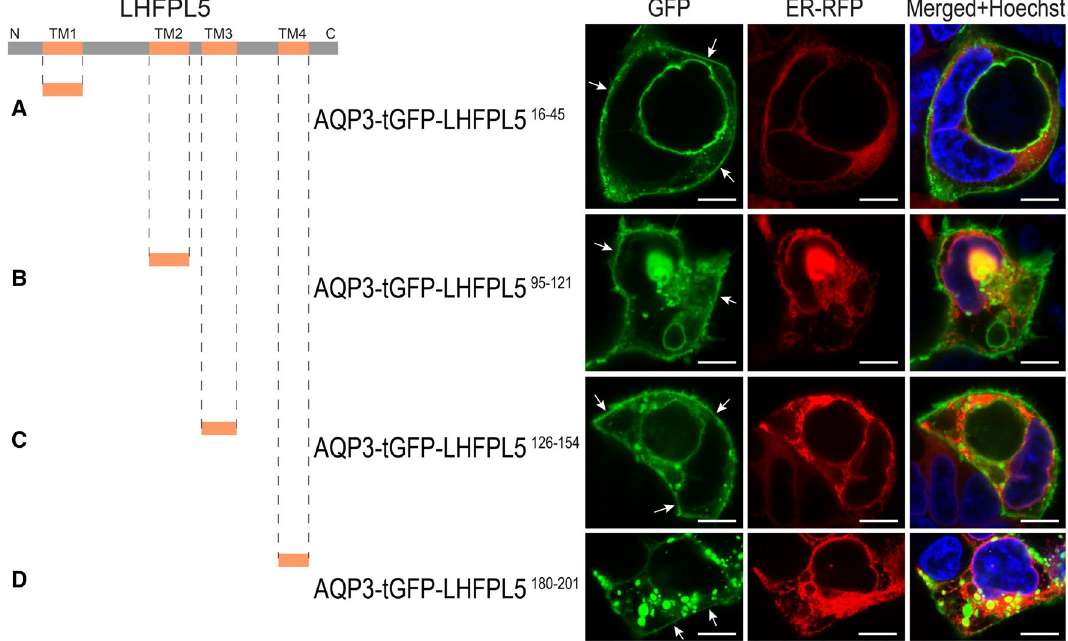
Figure 5. Assessing Transmembrane Segments of LHFPL5 for the ability to halt trafficking to the PM using AGR. ( A ) The first TM segment comprising residues of LHFPL5 16–45 does not prevent reporter trafficking to the PM. PM localization was detected in HEK 293 cells transfected with AQP3-tGFP-LHFPL5 16–45 (arrows). ( B–D ) Second TM segment amino acid sequence LHFPL5 95–121 ( B ), third TM sequence LHFPL5 126–154 ( C ) and fourth TM sequence LHFPL5 180–201 ( D ) also did not prevent PM localization. Scale bars: 10